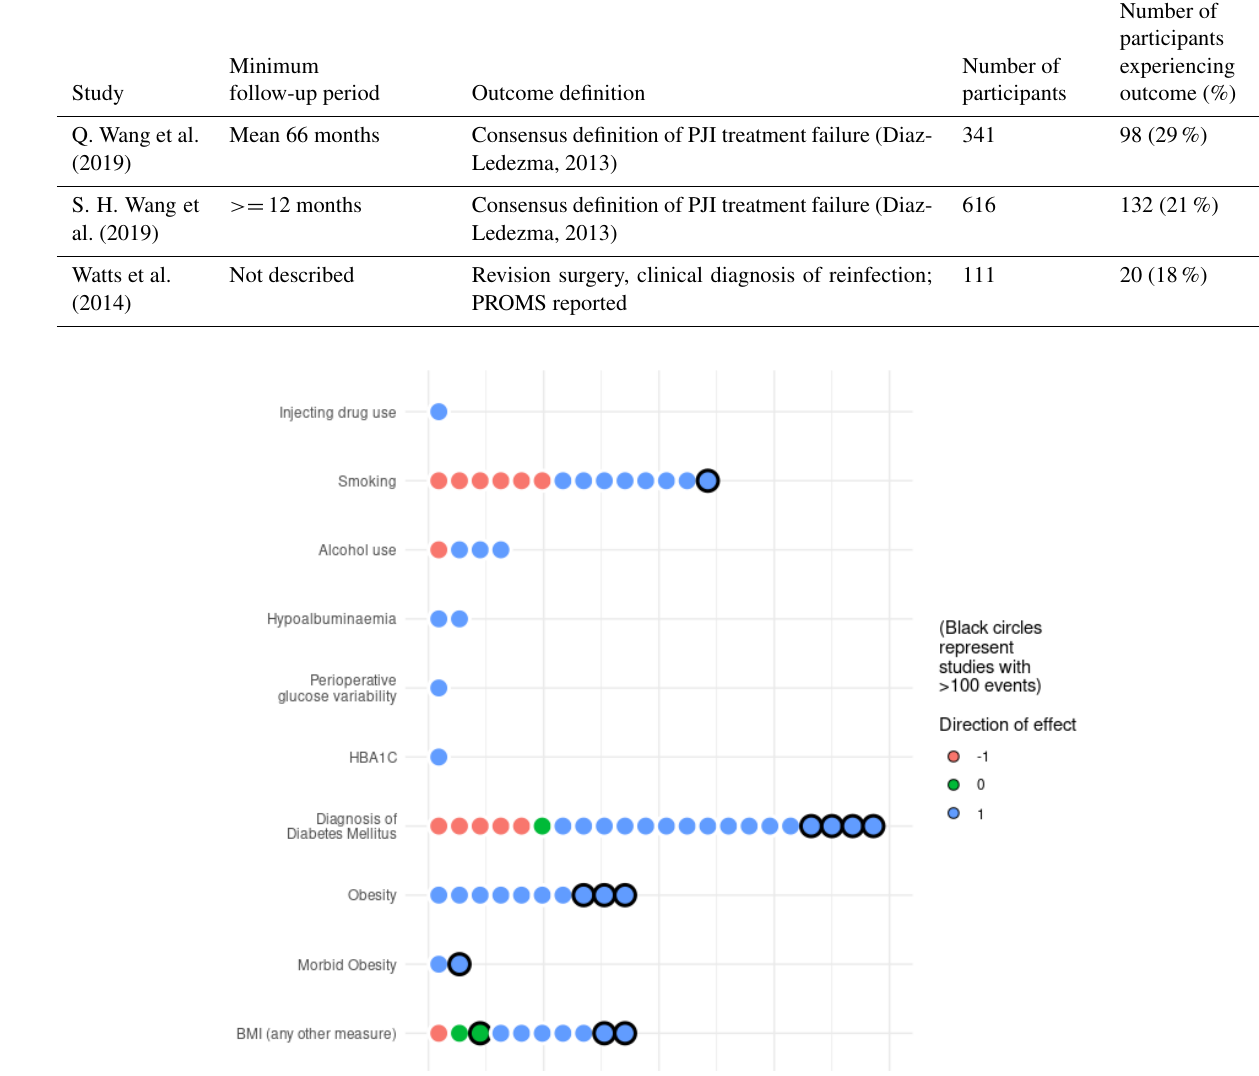
Figure 2. Direction of association for grouped variables representing prognostic factors of interest identified from included studies. Each circle represents the direction of association for one variable in one study. Note that all studies were assessed at a high risk of